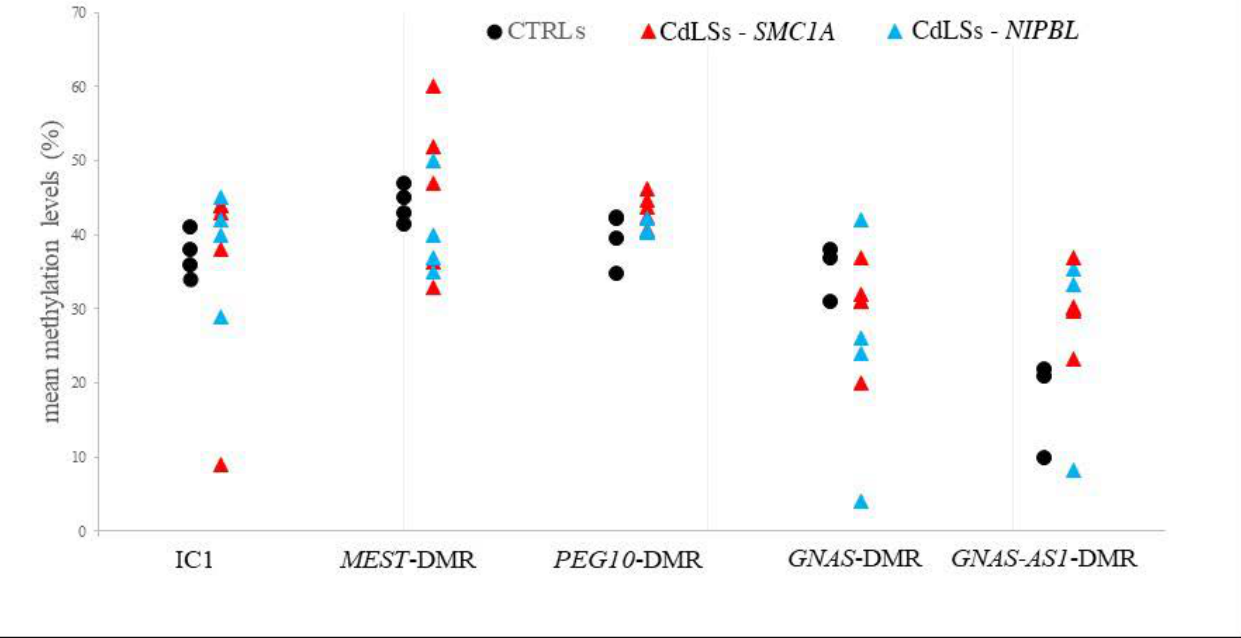
Figure 8. Quantitative CpGs methylation analysis of IGF2 / H19 (IC1), MEST, PEG10, GNAS and GNAS-AS1 DMRs from CTRL (black circles) and CdLS cell lines (red triangles: SMC1A mutation; light blue triangles: NIPBL mutation). Results are the mean of two independent pyrosequencing